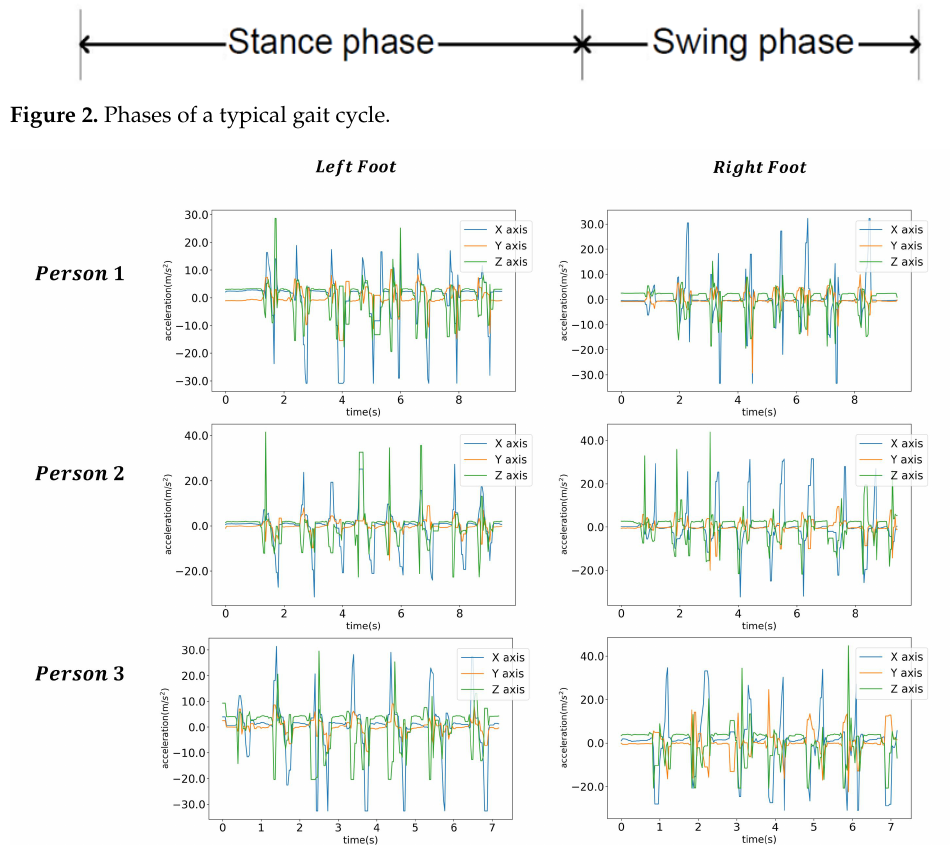
Figure 3. Exemplary accelerometer data for the